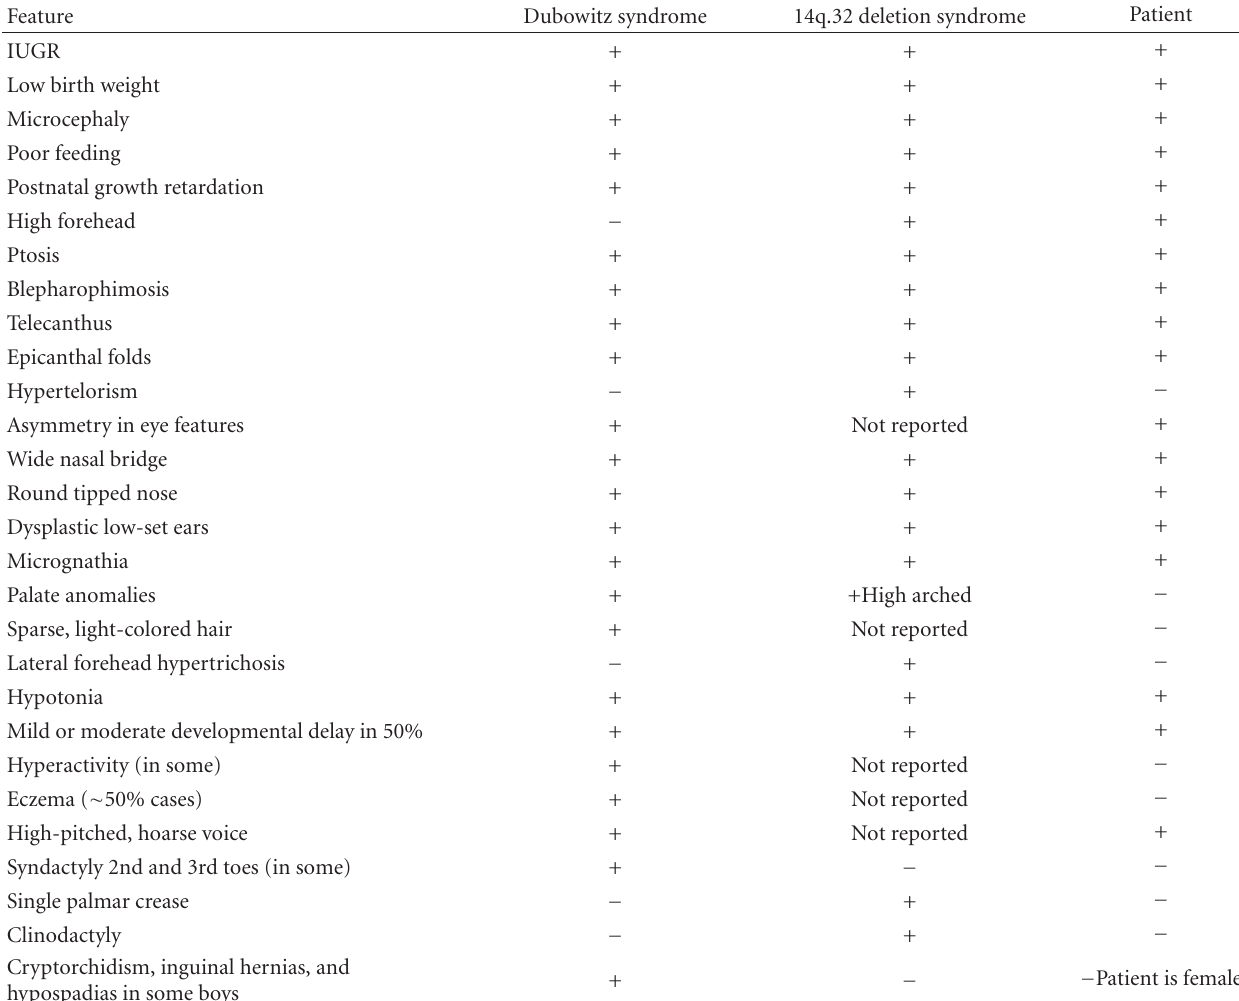
Table 1: Comparison between the clinical features of Dubowitz syndrome, 14q.32 deletion syndrome, and the